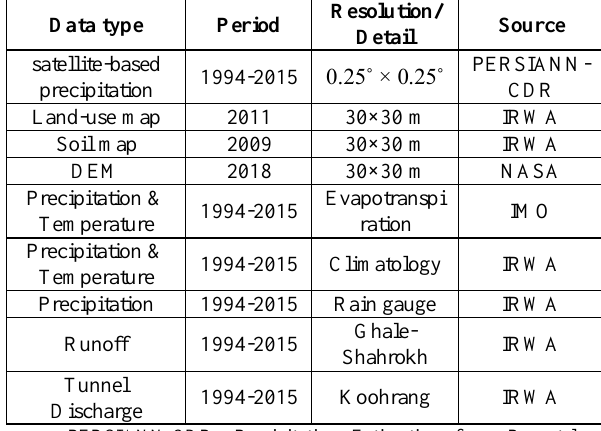
Table 1. Data description and sources .